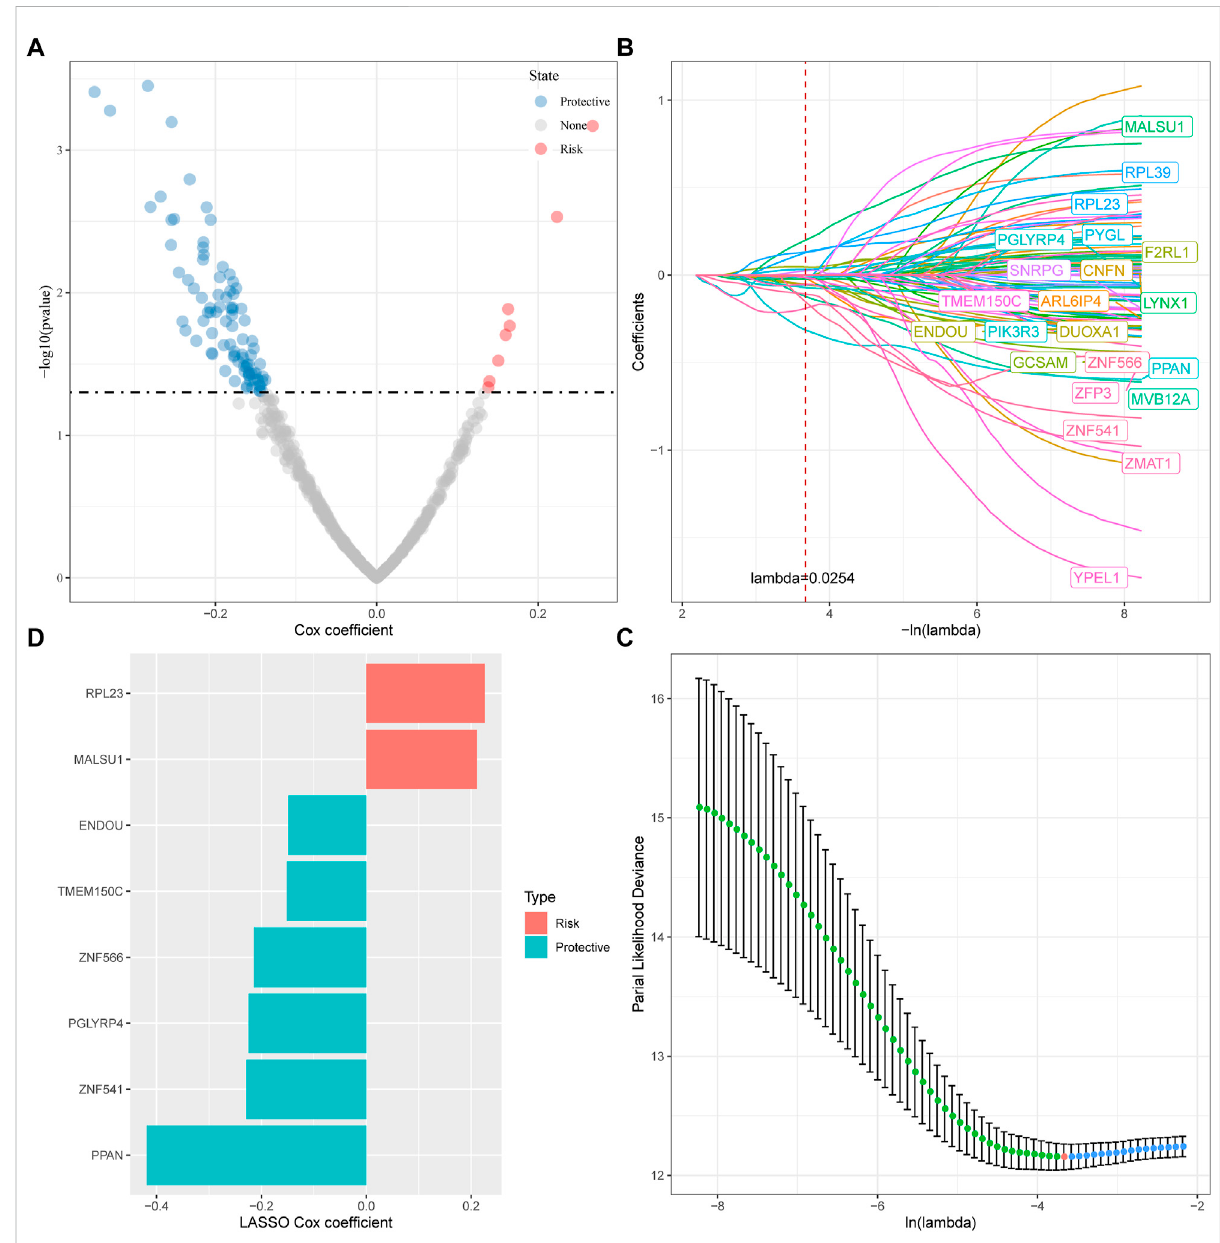
FIGURE 5 Determination of ferroptosis phenotype-related genes. (A) A total of promising candidates were identi fi ed through the correlation analysis of the gene expression and the Module Membership; (B) The trajectory of each independent variable with lambda; (C) Con fi dence interval under lambda; (D) Distribution of LASSO coef fi cients of the ferroptosis-related prognostic gene